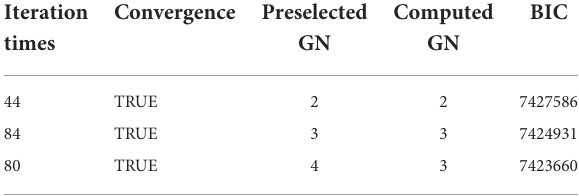
TABLE 1 Results of group number